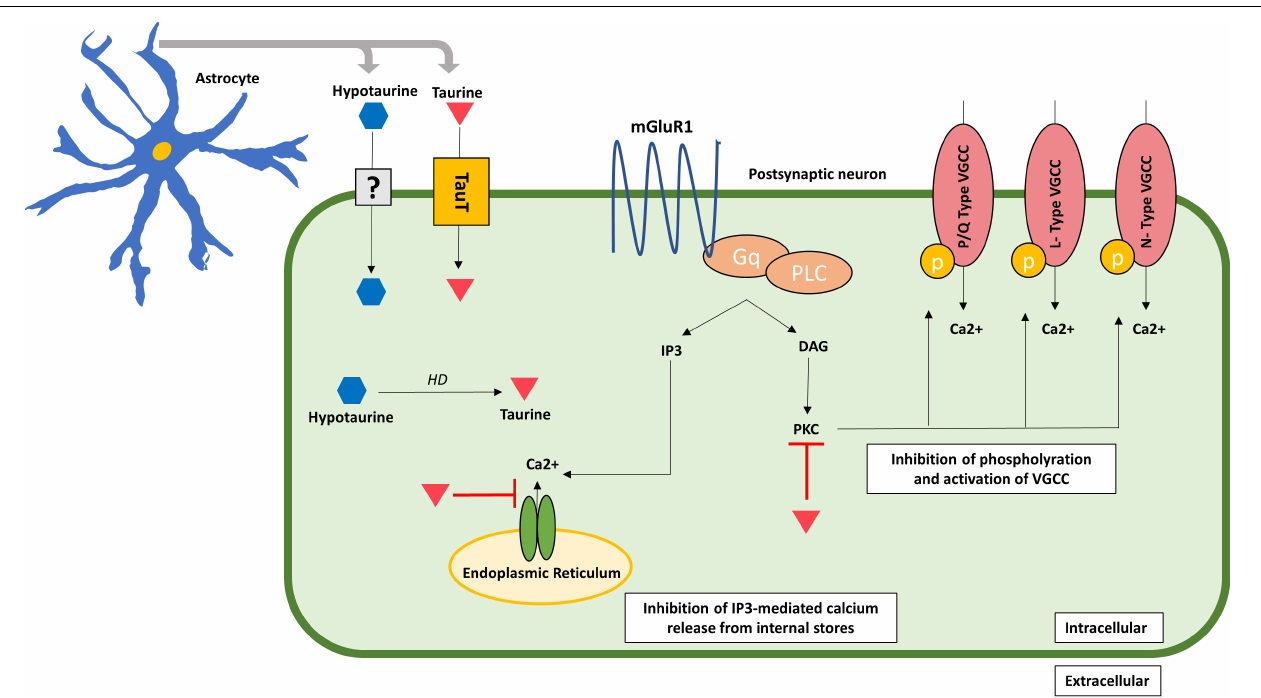
FIGURE 2 | Acute neuroprotective effects of taurine in the post-synaptic neuron. Taurine inhibits calcium influx by inhibiting the IP3-mediated calcium release from internal storages and blocking PKC activity, which inhibits phosphorylation and activation of VGCC consequently decreasing calcium entry through these channels. Taurine is represented by an inverted red triangle, while hypotaurine is represented by a blue hexagon. DAG, diacylglycerol; IP3, inositol trisphosphate; mGluR1, metabotropic glutamate receptor type 1; PLC, phospholipase C; PKC, protein kinase C; TauT, taurine transporter; uncertain receptor/transporter–represented by a question mark; VGCC, voltage-gated calcium